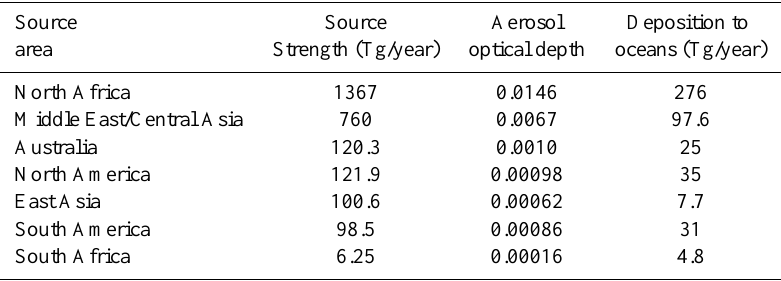
Table 2. Source Apportionment: the relative strength of the different sources in the source apportionment simulations. The values represent the total contribution of the source area to the globally averaged aerosol optical depth and deposition to